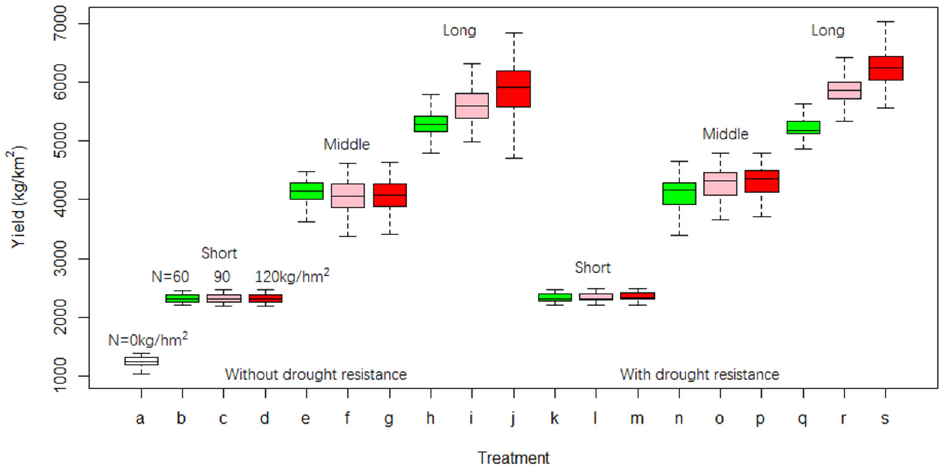
Figure 6. Changes in national maize yields and their ranges under the management strategies a–s outlined in Table 1.